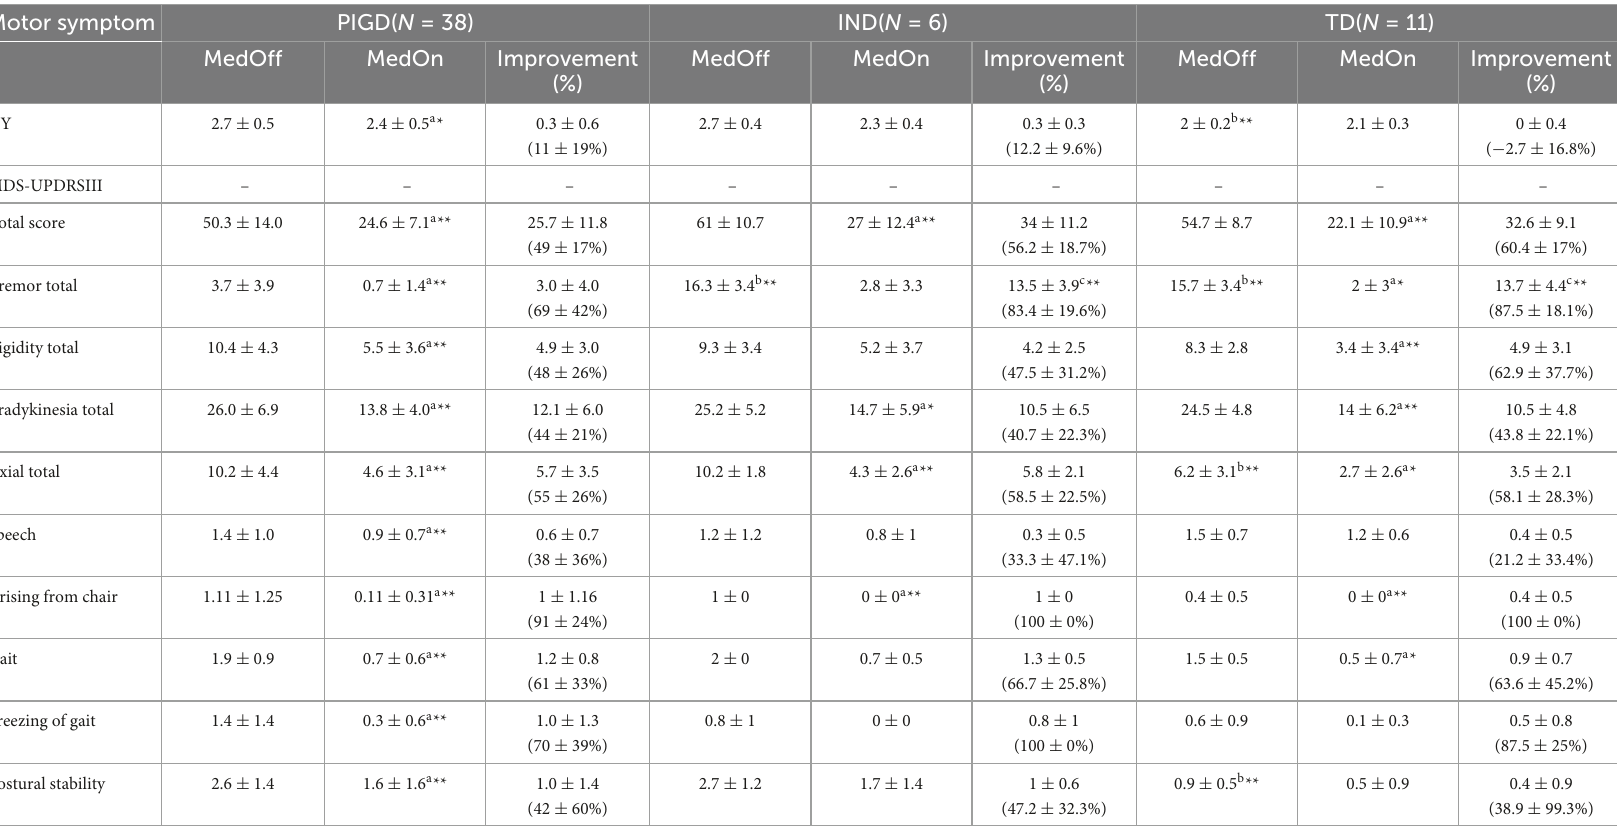
TABLE 3 Baseline characteristics of the patients with different motor